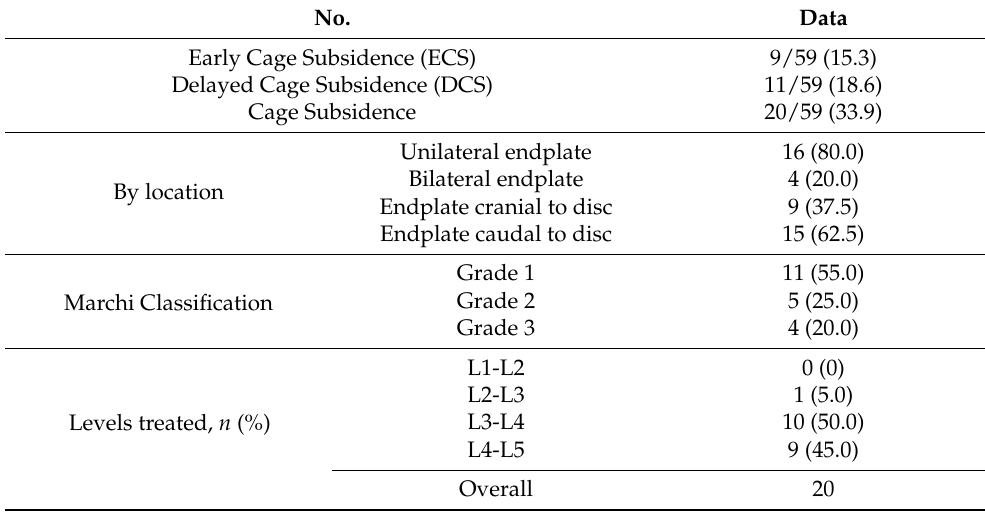
Table 2. The numbers of segments with cage subsidence according to the location, types and disc